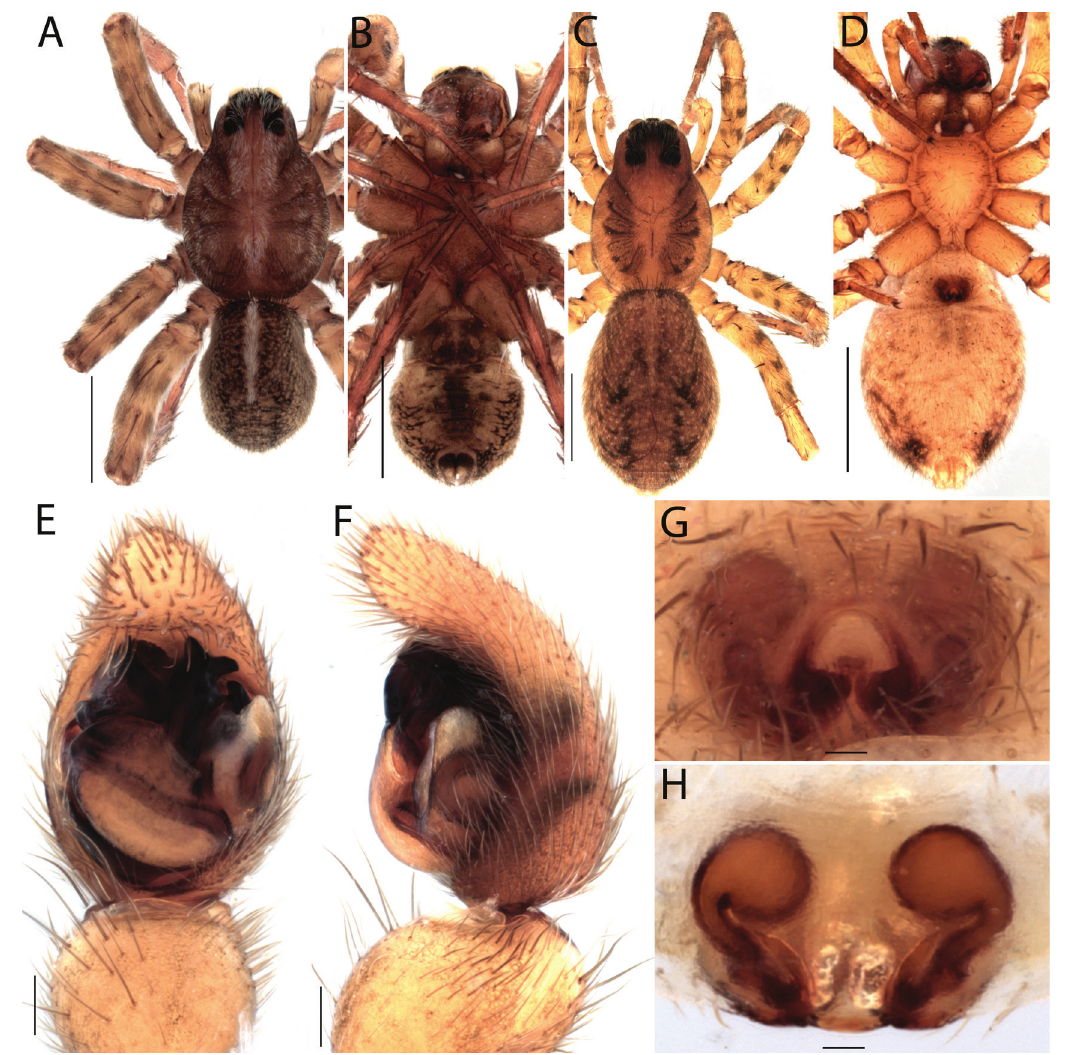
Figure 38. Artoria taeniifera Simon, 1909, male (WAM 98/2179), female (AM KS50283): A , male habitus, dorsal view; B , male habitus, ventral view; C , female habitus, dorsal view; D , female habitus, ventral view; E, male pedipalp, ventral view; F , male pedipalp, retrolateral view; G , epigyne, ventral view; H , epigyne, dorsal view. Scale bars: habitus 1.0 mm; pedipalp, epigyne 0.1